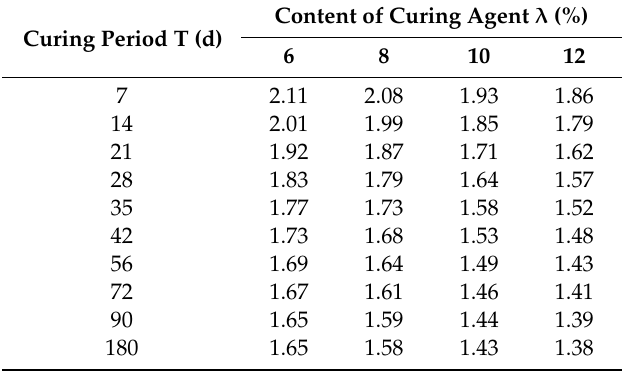
Table 5. The average equivalent aperture size of the solidified calcareous sand ( µ m). Curing Period T